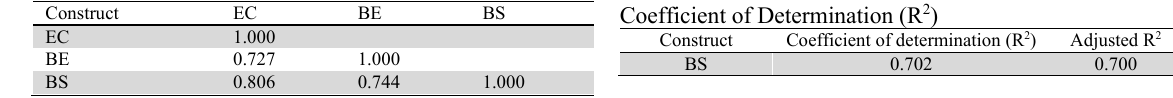
Inter-construct Correlation